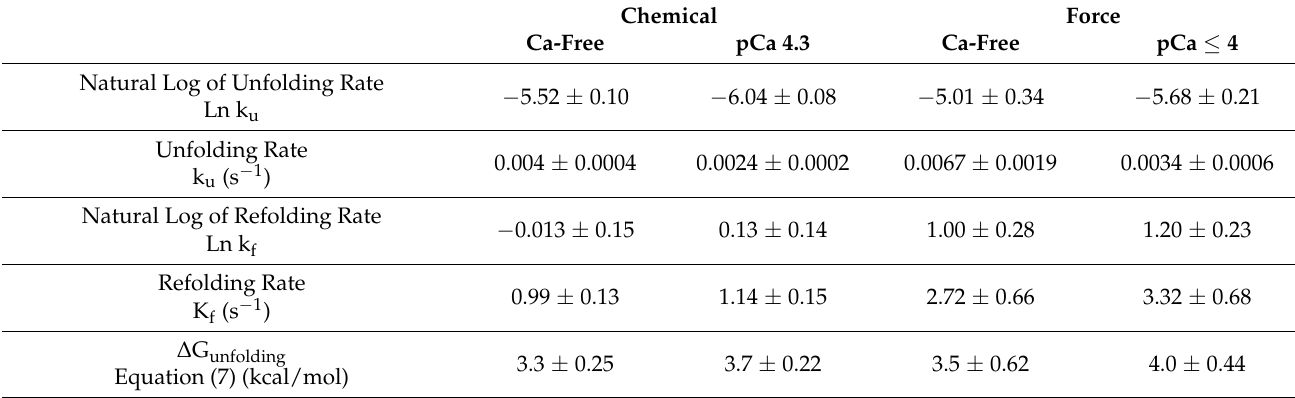
Figure 6. Chevron plots for I83 yield similar, but different rate constants at zero denaturant and zero force. ( A ) The natural log of unfolding rate constants for urea denaturation yielded slower unfolding at pCa 4.3. Average values (N = 4) in the absence of calcium (black) and in the presence of calcium (gray) are shown ± one standard deviation. ( B ) The natural log of force ‐ induced unfolding and refolding rates illustrate slower unfolding between 30 and 40 pN and fast refolding at force ≤ 10 pN. Average values (N = 5) in the absence of calcium (black) and in the presence of calcium (gray) are shown ± one standard deviation. Table 2. Rate constants and free energy values indicated stabilization by calcium in both chemical and force unfolding.